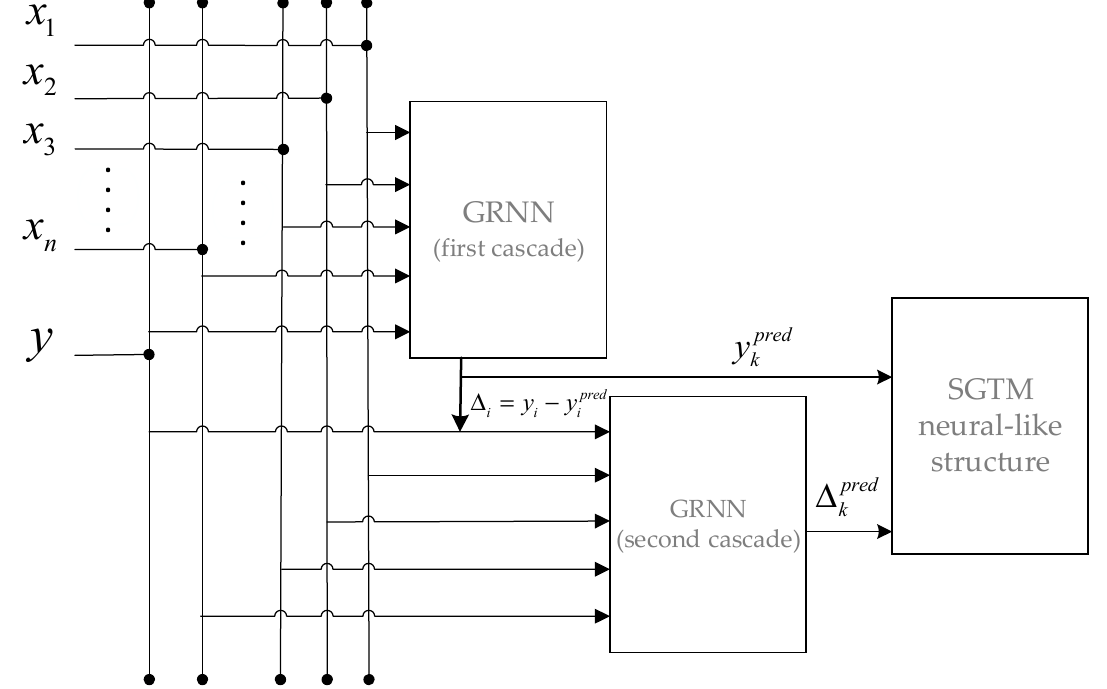
Figure 3. Flowchart of the GRNN–SGTM ensemble for solving the stated task.